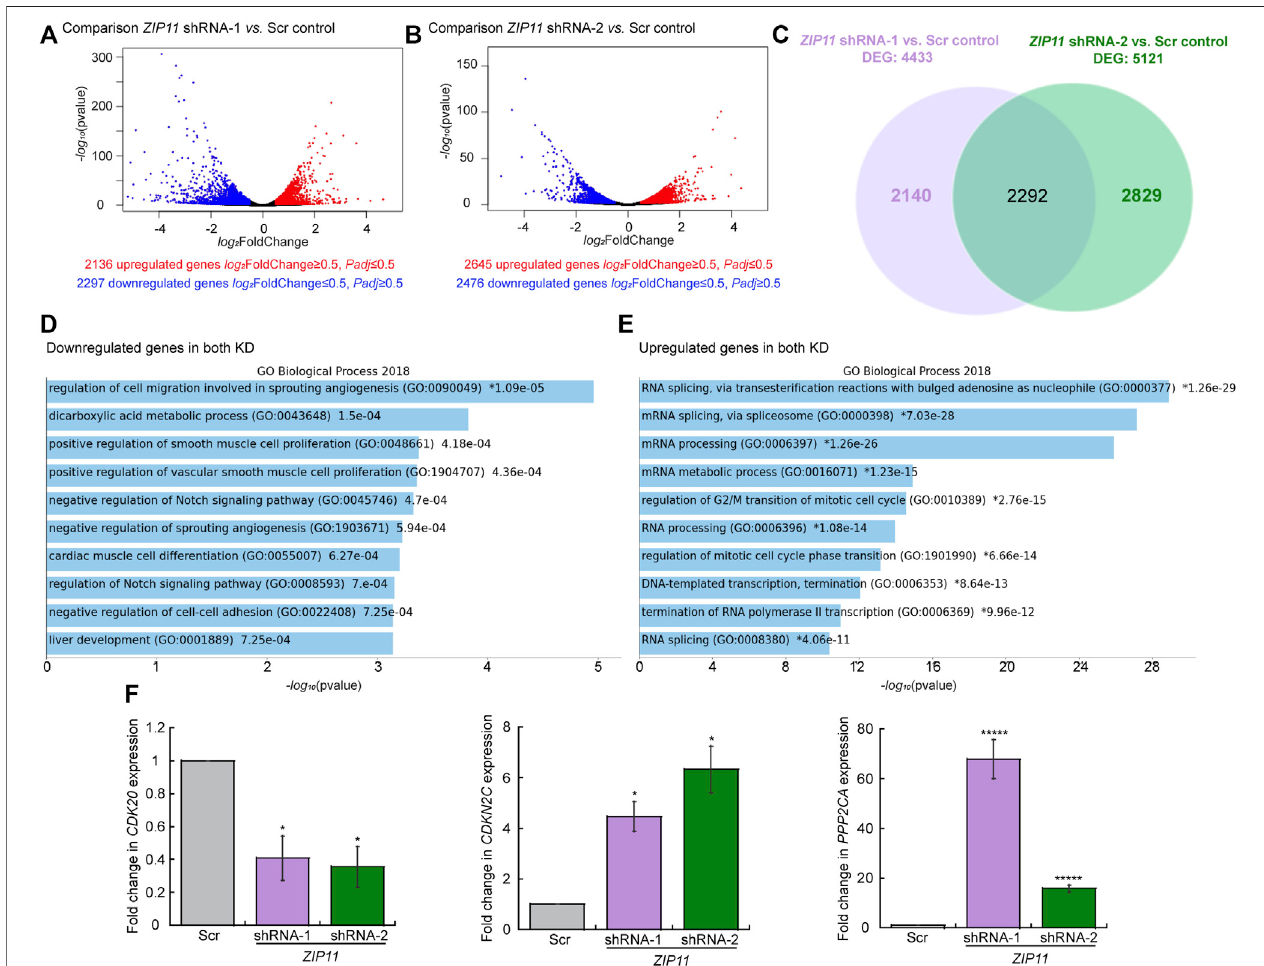
FIGURE 4 | Changes in gene expression dependent on ZIP11 knockdown in HeLa cells. Volcano plots displaying differentially expressed genes between Scr control and ZIP11 KD with shRNA1 (A) or shRNA2 (B) in HeLa cells. The y -axis corresponds to the mean log10 expression levels ( p values). The red and blue dots represent the up- and down-regulated transcripts in ZIP11 KD (false-discovery rate [FDR] of < 0.05), respectively. The gray dots represent the expression levels of transcripts that did not reach statistical signi fi cance (FDR of > 0.05). (C) Venn diagram showing the overlapping DEG between the two shRNAs used to KD ZIP11 . GO term analysis of down-regulated (D) or up-regulate (E) genes consistent in both KD of ZIP11 in HeLa cells. Cut-off was set at 2.0 of the − log(adjusted p value). See Supplementary Table S4 for the complete list of genes and individual GO terms detected for each shRNA using Panther. (F) Steady state mRNA levels determined by qRT-PCR ofrepresentative downregulated( CDK20 ) and up-regulated ( CDKN2C and PPP2CA ) genesselected from theRNA-seqanalyseswhichare associatedto cell cycle progression and apoptosis. Data are the mean ± SE for three independent experiments. * p < 0.05, ***** p < 0.00001.